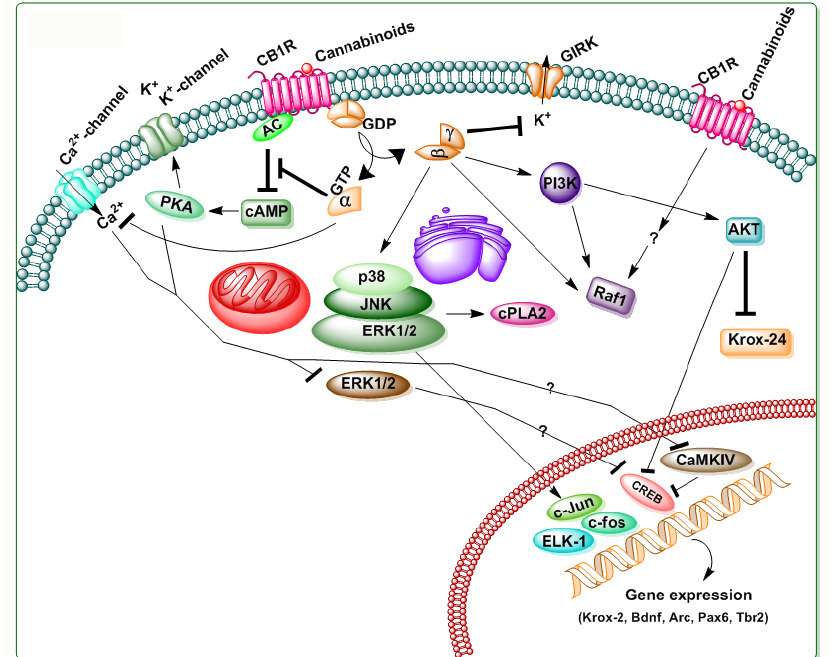
Figure 4. Schematic illustration of the CB1R mediated signaling. ∆ 9 -tetrahydrocannabinol ( ∆ 9 -THC) and other SCBs produce their effects via binding to CB1Rs, a 7-transmembrane domain G-protein coupled receptor located in the cell membrane. The Ca 2+ channels inhibited by CB1R stimulation include N-, P/Q-, and L-type channels. The actions on Ca 2+ channels and adenylyl cyclase (AC) are thought to be mediated by the α subunits of the G-protein, and the e ff ects on G protein-coupled inward rectifying K + (GIRK) and PI3K are considered to be mediated by the βγ subunits. AC inhibition and the subsequent decrease in cyclic adenosine monophosphate (cAMP) lead to the inhibition of cAMP-dependent protein kinase (PKA). This leads to decreased K + channels and pCaMIV and pCREB levels, which might lead to the inhibition of gene expression required for several physiological functions. Stimulatory effects are indicated by ( → ) symbols and inhibitory effects by ( ⊥ ) symbols. CB2R belongs to the seven-transmembrane domain class of GPCRs. CB2R is also coupled to G i / o